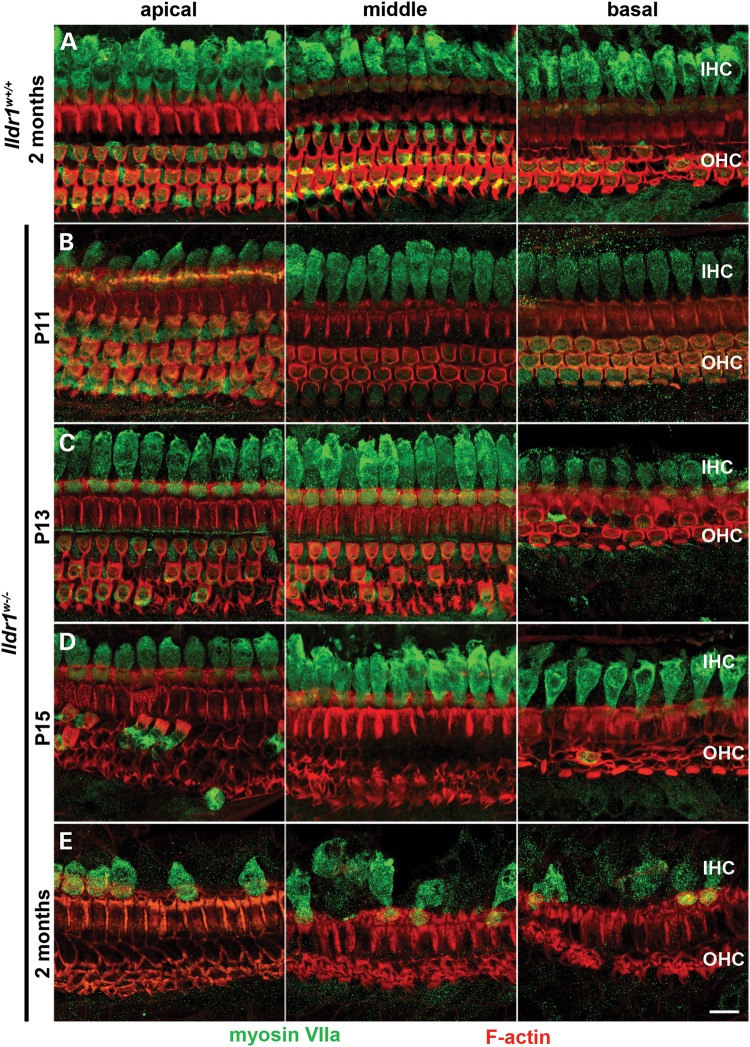
OHCs of Ildr1w−/− mice rapidly degenerate around hearing onset followed by a slow IHC loss in adult mice. Maximum intensity projections show degeneration of auditory HCs in Ildr1w−/− mice. Hair cell bodies were probed with antibody against myosin VIIa (green) and F-actin was labeled with phalloidin (red). (A) Apical, middle and basal sensory epithelium in adult, 2 month old Ildr1w+/+ control mice. (B–E) Apical, middle and basal sensory epithelium from P11 Ildr1w−/−, P13 Ildr1w−/−, P15 Ildr1w−/−, and adult Ildr1w−/− mice indicate that HCs develop normally but OHCs begin to degenerate around hearing onset. (E) In adult, 2 month old Ildr1w−/− mice, gradual loss of IHCs is observed. Scale bar: 10 µm.